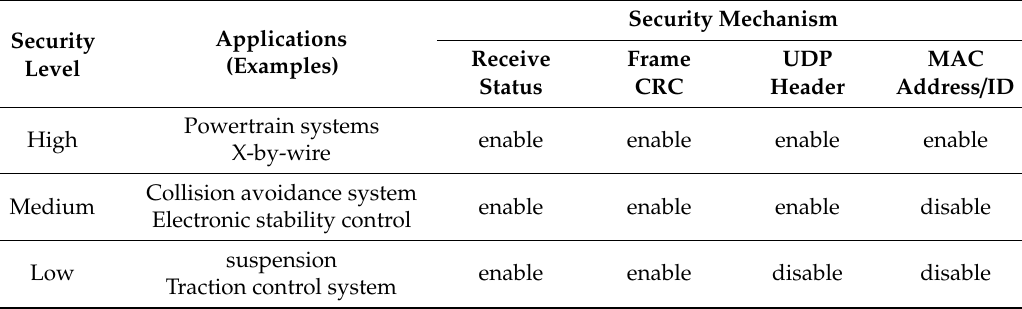
Table 2. Risk-control